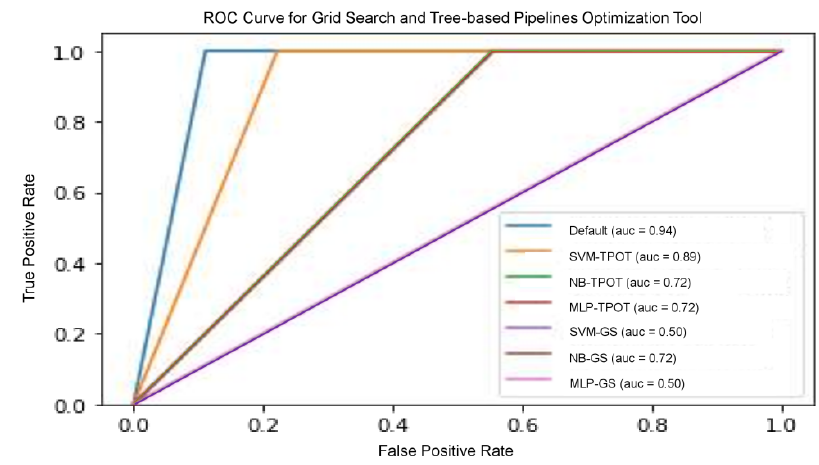
Figure 6. ROC curve for grid search and tree-based pipeline optimization configuration on various ML classifiers.